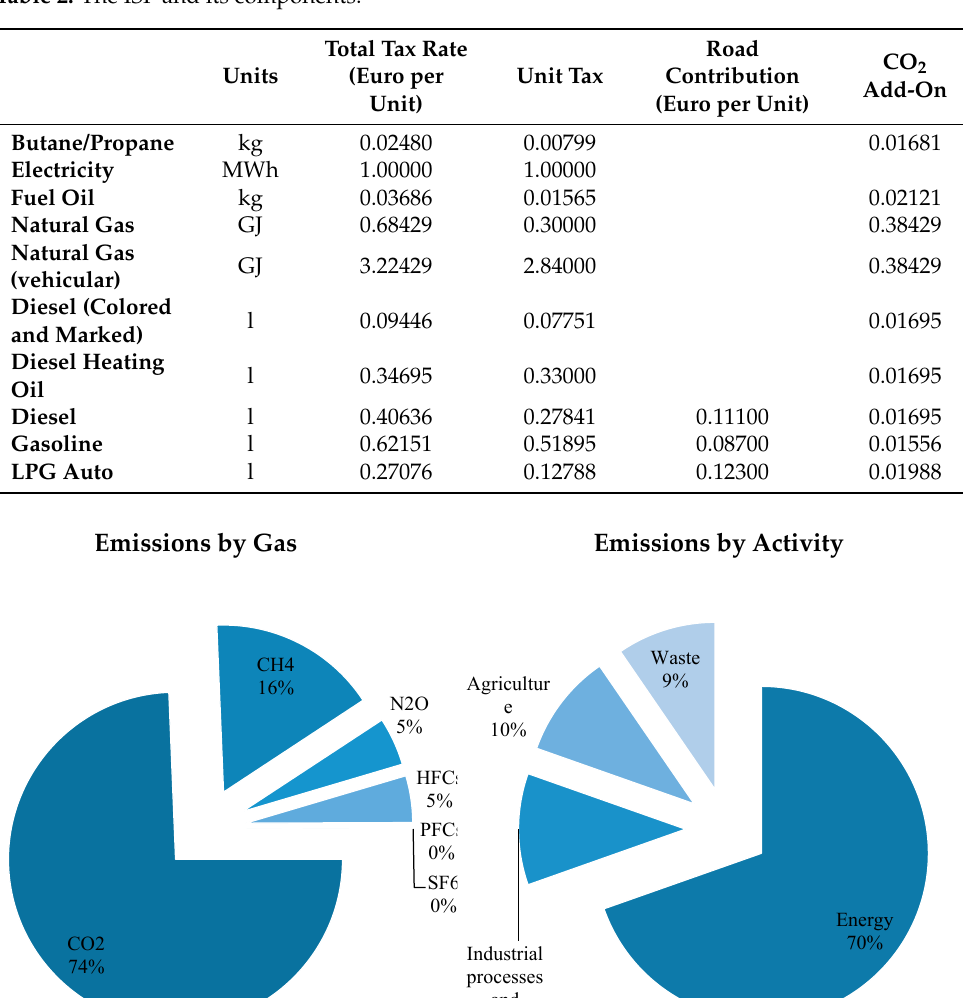
Table 2. The ISP and its components.